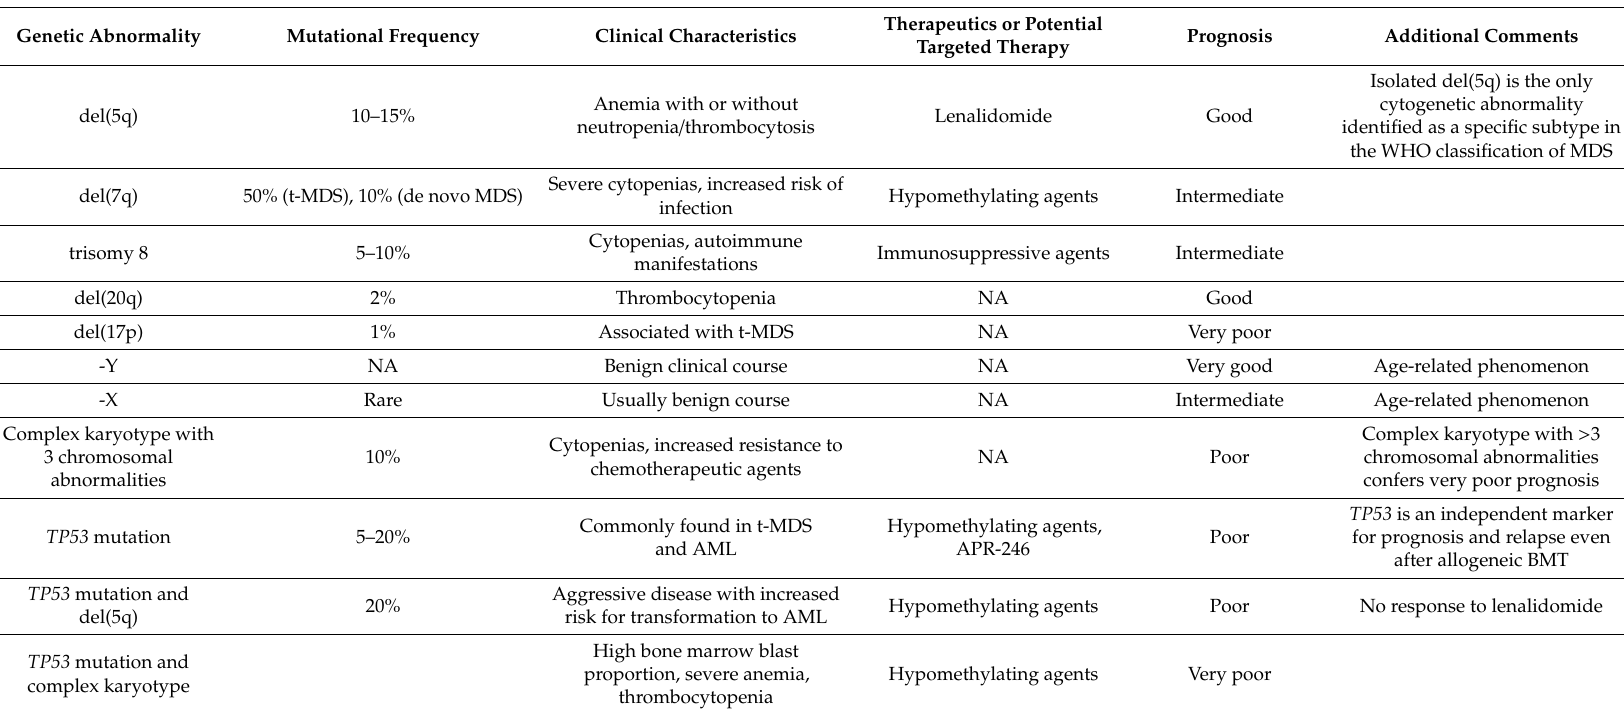
Table 2. The clinical characteristics, prognoses, and potential targeted treatments in MDS patients with selected genetic